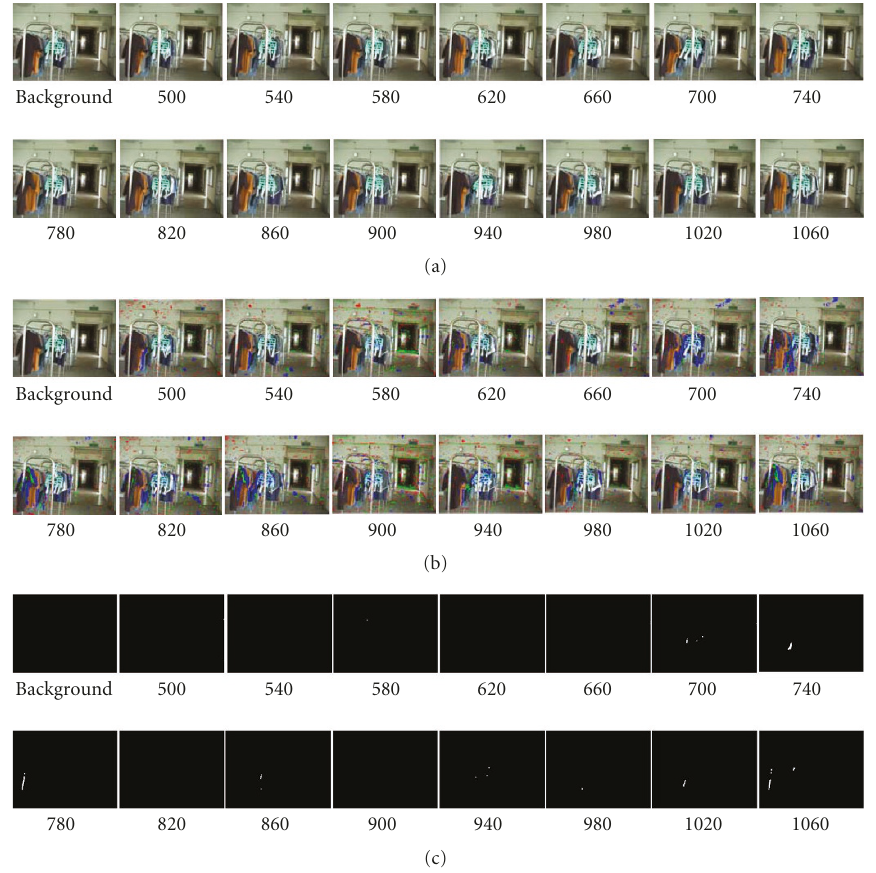
Figure 10: The results of background subtraction about dynamic background, (a) original images, (b) the results of pixel classification, where red color indicates the shadow, green indicates the highlight, and blue indicates the foreground, (c) the results of background subtraction with shadow removal using our proposed method, where dark indicates the background and white indicates the foreground.